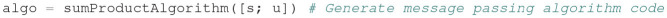
ForneyLab command for automated generation of the message passing algorithm for inference in the Bayesian thermostat simulation. The sum-product algorithm implicitly assumes the recognition model of Equation (11). ForneyLab also supports generating message passing code for alternative constraints on the recognition distribution (see e.g., Cox et al., 2018).